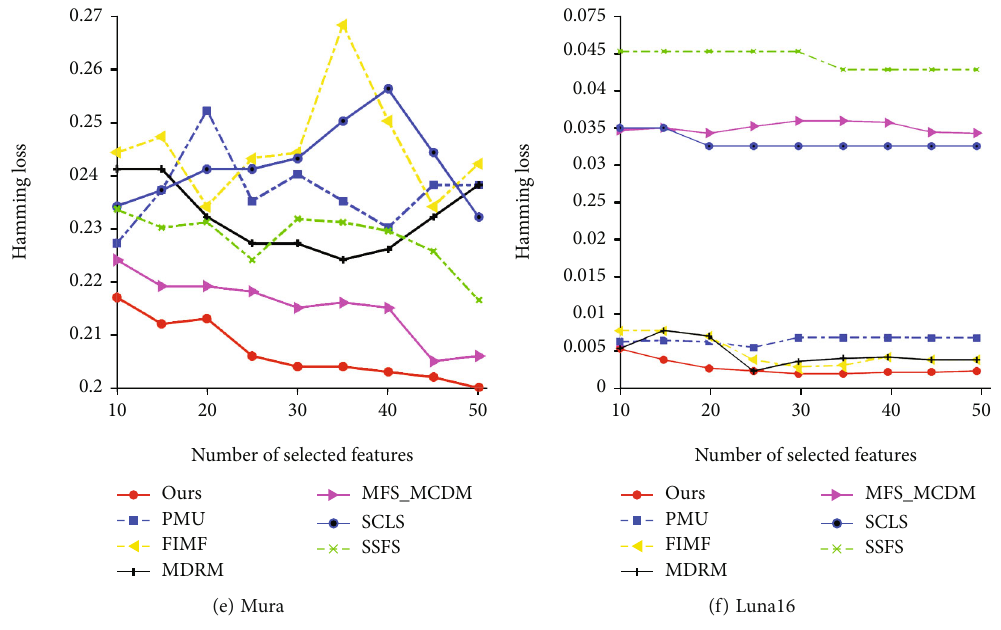
Figure 2: Hamming loss: the quality of each algorithm varies with the selected feature